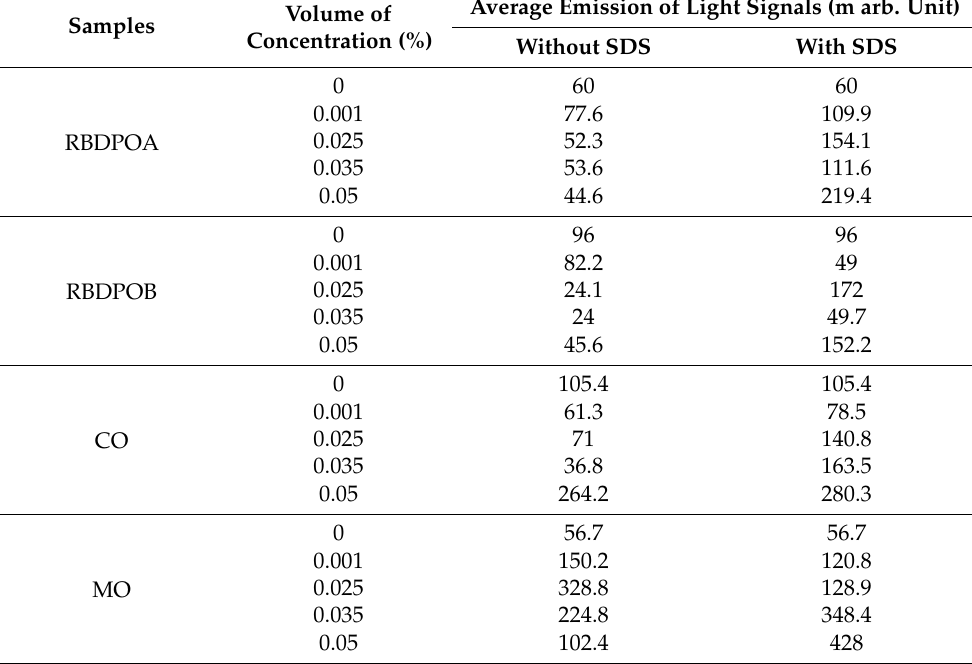
Table 2. Average emission of light signals of RBDPO, CO and MO based Al 2 O 3 nanofluids at 30 kV applied